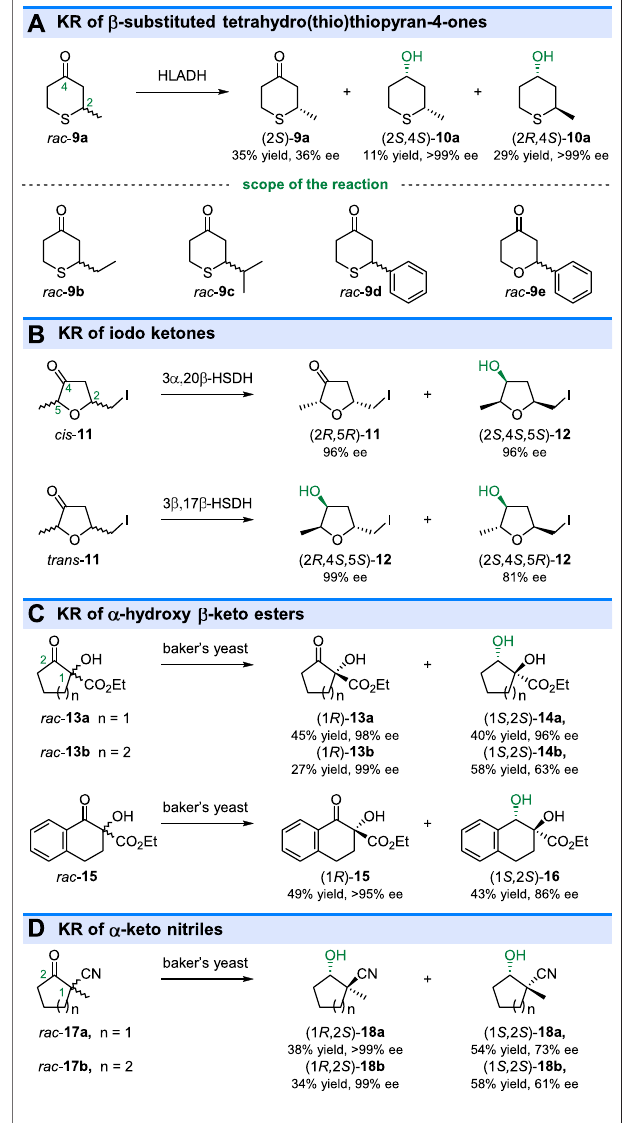
FIGURE4| Kinetic resolutionofsubstituted monocyclicketones. (A) KR of β -substituted tetrahydro(thio)thiopyran-4-ones, (B) KR of iodo ketones, (C) KR of α -hydroxy β -keto esters, and (D) KR of α -keto